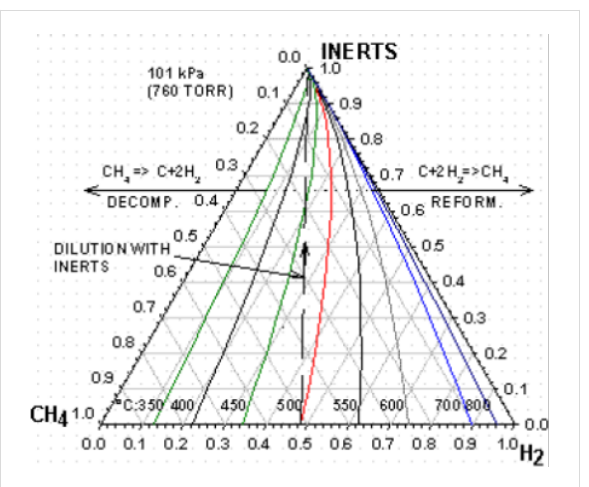
Figure 1: Methane decomposition equilibrium in the presence of inert gas at different temperatures. Reprinted with permission from [64], copyright 2002 Taylor and Francis